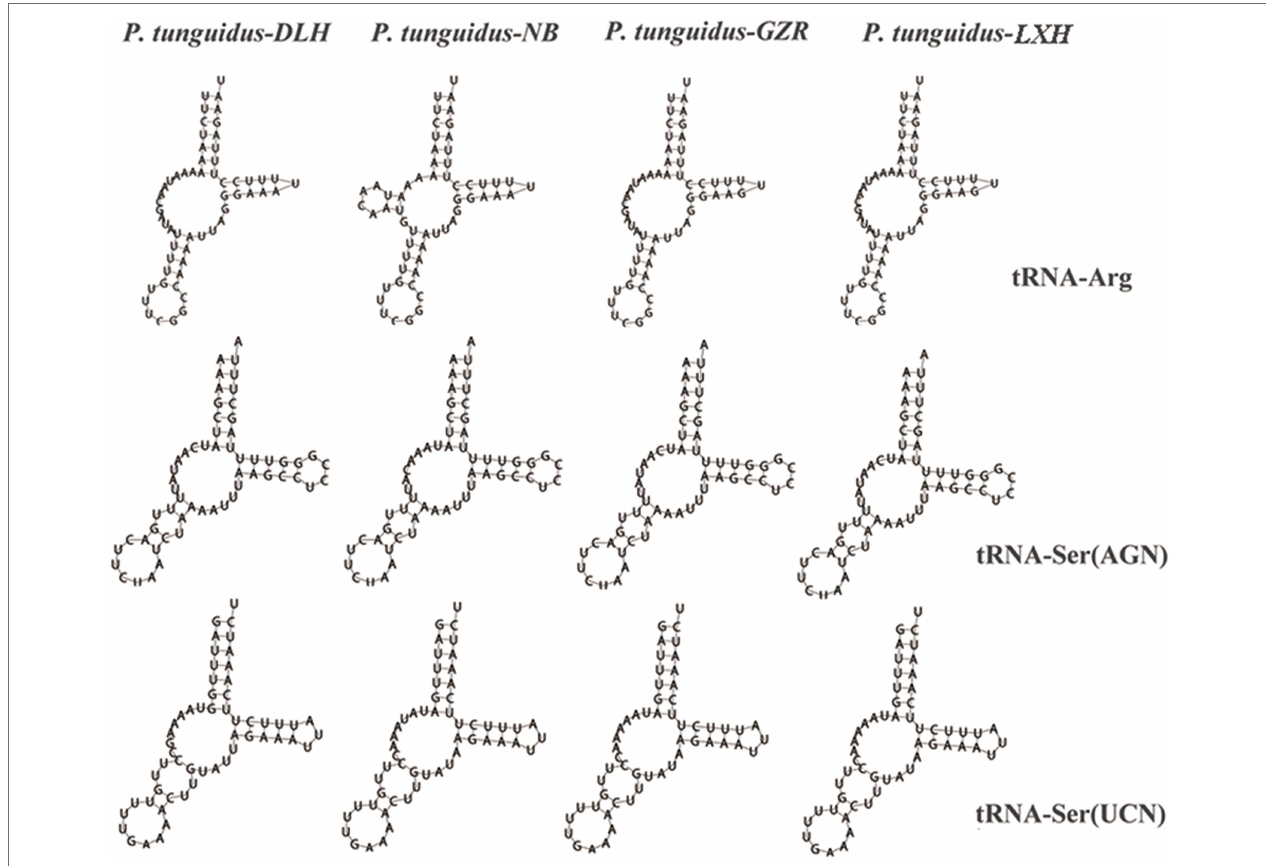
FIGURE 5 | Secondary structures of three transfer tRNA genes from the four representative P. tunguidus